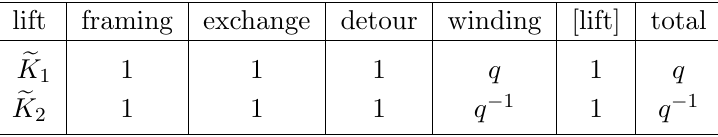
Table 1 . Summary for the two lifts of the unknot K in (cid:12)gure